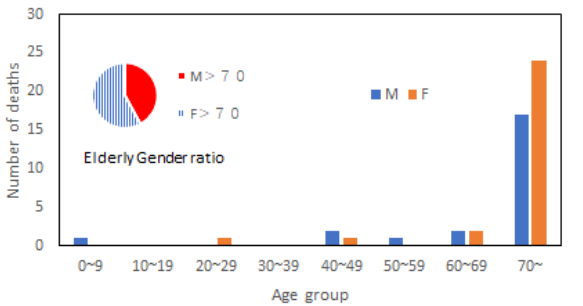
Figure 7. Death tolls in different age groups and elderly gender ratio in Mabi Town.